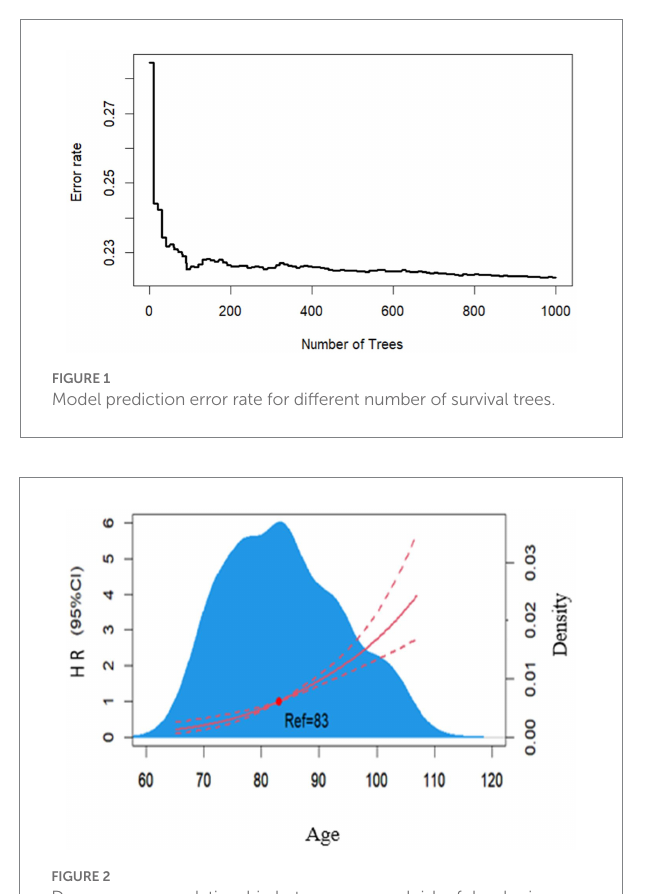
FIGURE 2 Dose–response relationship between age and risk of developing cognitive impairment in a multifactorial model. The blue area is the kernel density plot for age, and the red curve is the sample smoothing curve for